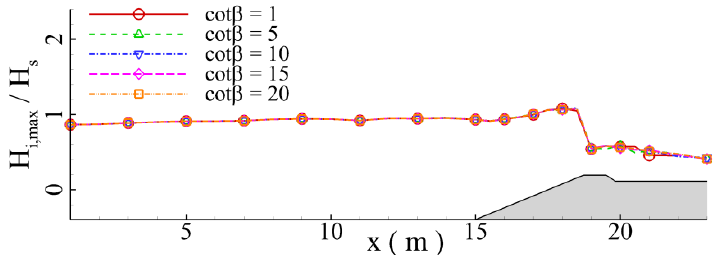
Figure 49. Maximum water elevation at the reef crest versus the backreef slope.